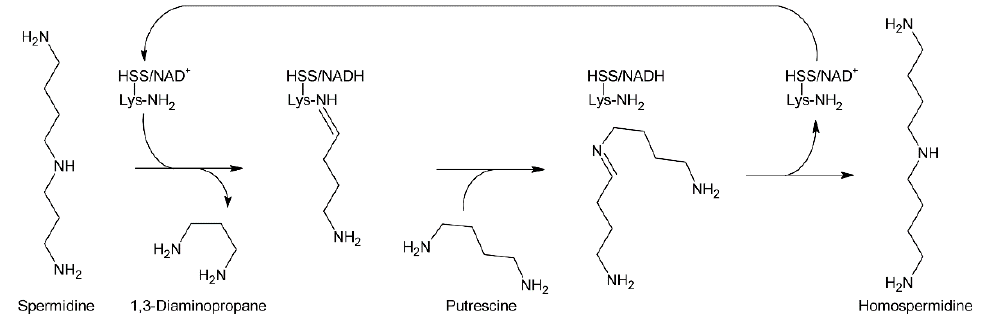
Figure 8. Mechanism of homospermidine formation by HSS. The amino group of a lysine residue of HSS reacts with spermidine, which releases 1,3-diaminopropane and reduces HSS-bound NAD + to NADH. Next, the residue is transferred to putrescine, forming an imine intermediate, which is reduced by the HSS-bound NADH to release homospermidine and recycle the HSS/NAD + complex. Adapted from [72].